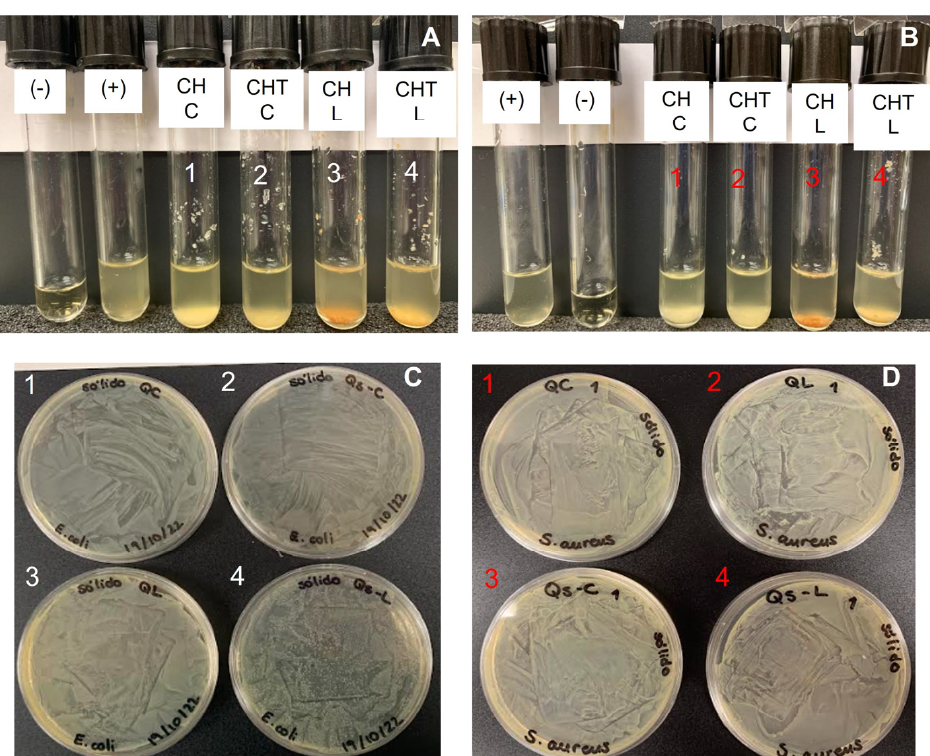
Figure 6. Antimicrobial activity of chitin (CH) and chitosan (CHT) powder from crab (C) and lobster (L) against E. coli ( A ) and S. aureus ( B ). Growth on plates of antimicrobial assay tubes of E. coli ( C ) and S. aureus ( D ). Tube (+) is positive control and tube (–) is negative control. Table 2. Antimicrobial activity of chitin and chitosan, from different sources, in powder form.